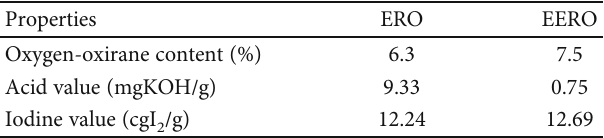
Table 1: Some characteristics of epoxidized rubber seed oils. Properties